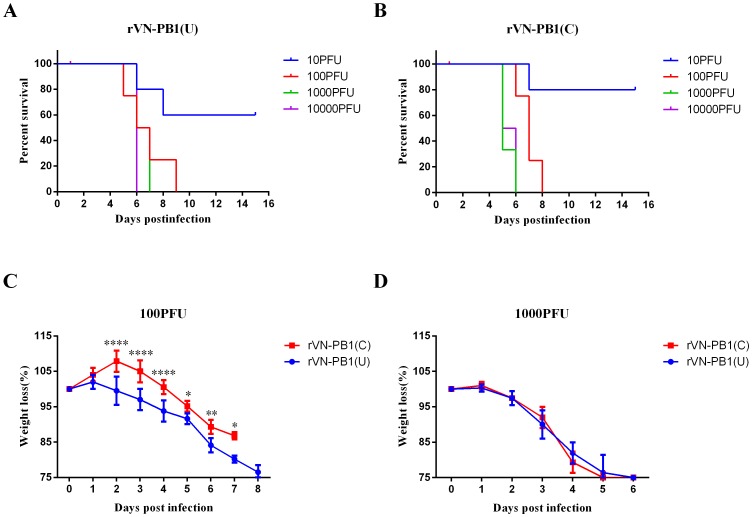
Duration of survival and weight loss in Balb/c mice infected with viruses containing U4 and C4.The durations of survival of mice infected with rVN-PB1(U) (A) and rVN-PB1(C) (B) with increasing doses of virus were recorded for 15 days. The LD50 titers (median lethal dose, 50% mouse lethal dose) were calculated using the method described by Reed and Muench in 1938 and expressed in PFU. Results showed 13.6 PFU for rVN-PB1(U) and 23.7 PFU for rVN-PB1(C), respectively. (C) and (D) Weight loss of mice infected with rVN-PB1(U) and rVN-PB1(C) at 100 PFU and 1000 PFU. The mean relative activity and standard deviation (error bar) were calculated. The data were analyzed with two-way ANOVA using GraphPad Prism Software, and the P values were calculated. (*) P<0.05; (**) P<0.01; (***) P<0.001, (****) P<0.0001.